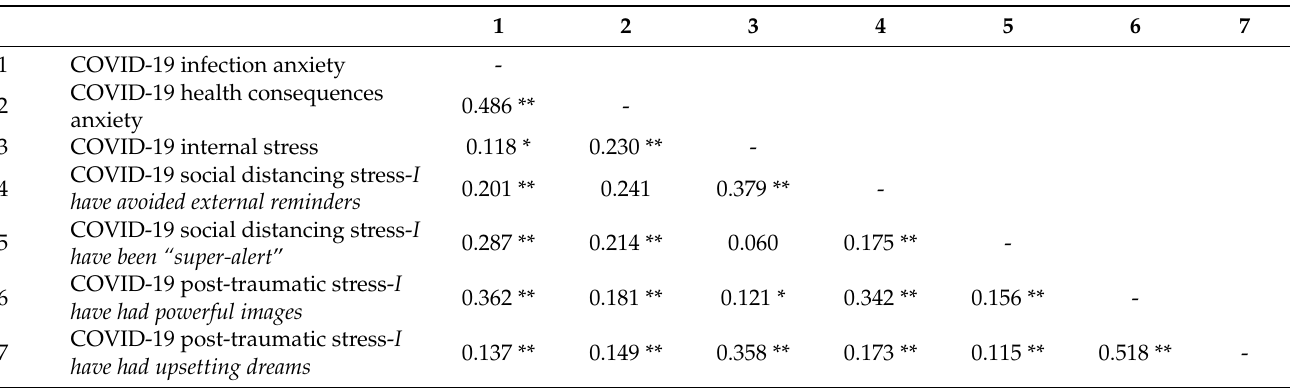
Table 7. Correlations between the subscales in the